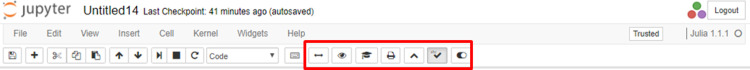
Enabled notebook extension icons shown in red box.